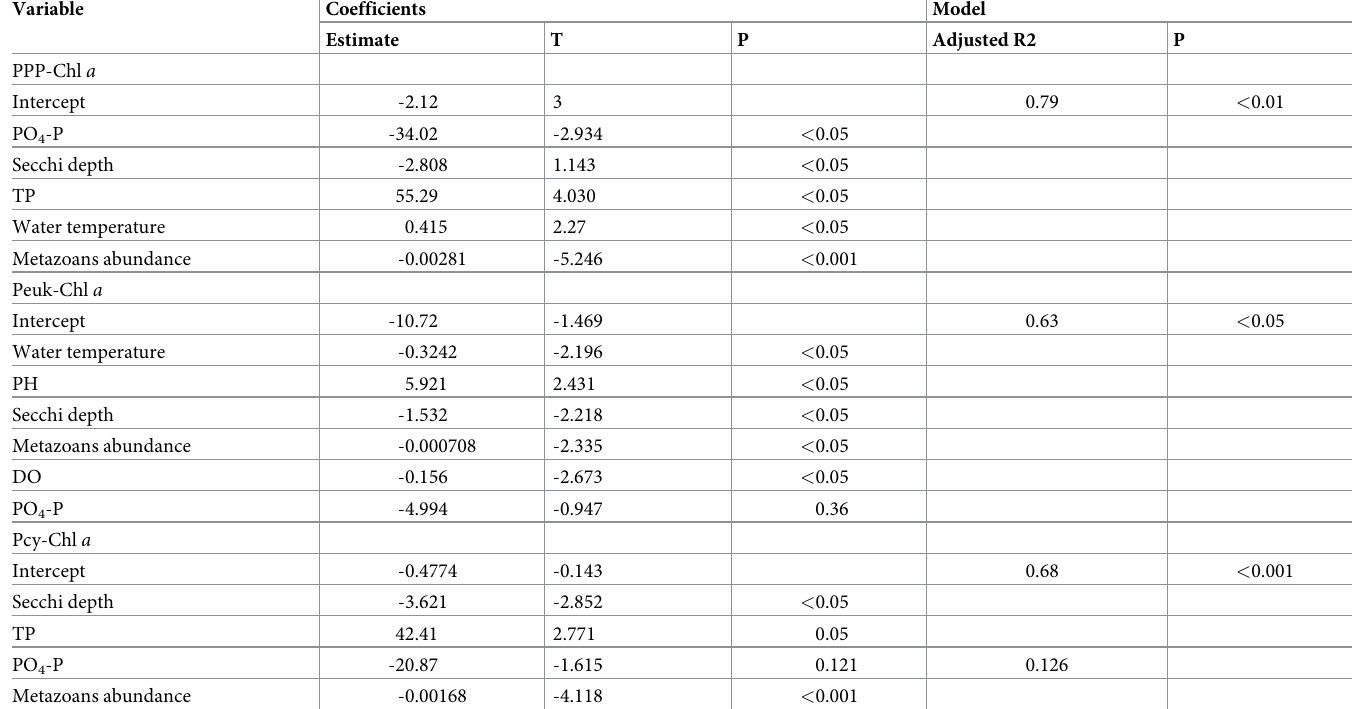
Table 2. Results of multiple linear regression models for predicting the Chl a biomass of photoautotrophic picoplankton (PPP-Chl a ), picoeukaryote Chl a (Peuk- Chl a ) and picocyanobacteria Chl a (Pcy-Chl a ) in Lake V õ